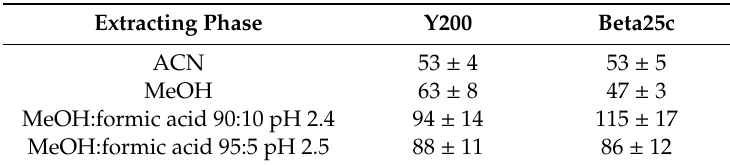
Table 3. Percentage Release of KTP at an Initial Concentration of 1 mg L − 1 from Y200 and Beta25c ( ± SD: Standard Deviation). Extracting Phase